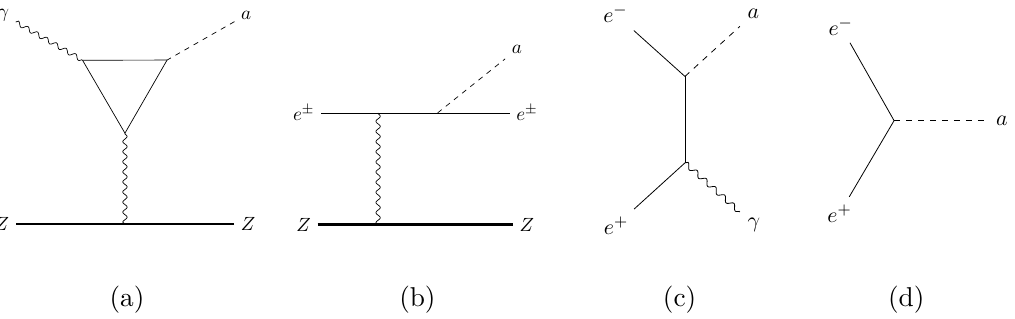
Figure 1 . Feynman diagrams for the four different production mechanisms of ALPs in our model in the E137 beam dump experiment: (a) Primakoff production (b) bremsstrahlung (both off a target nucleus of atomic number Z) (c) non-resonant e + e − annihilation (d) resonant e + e −